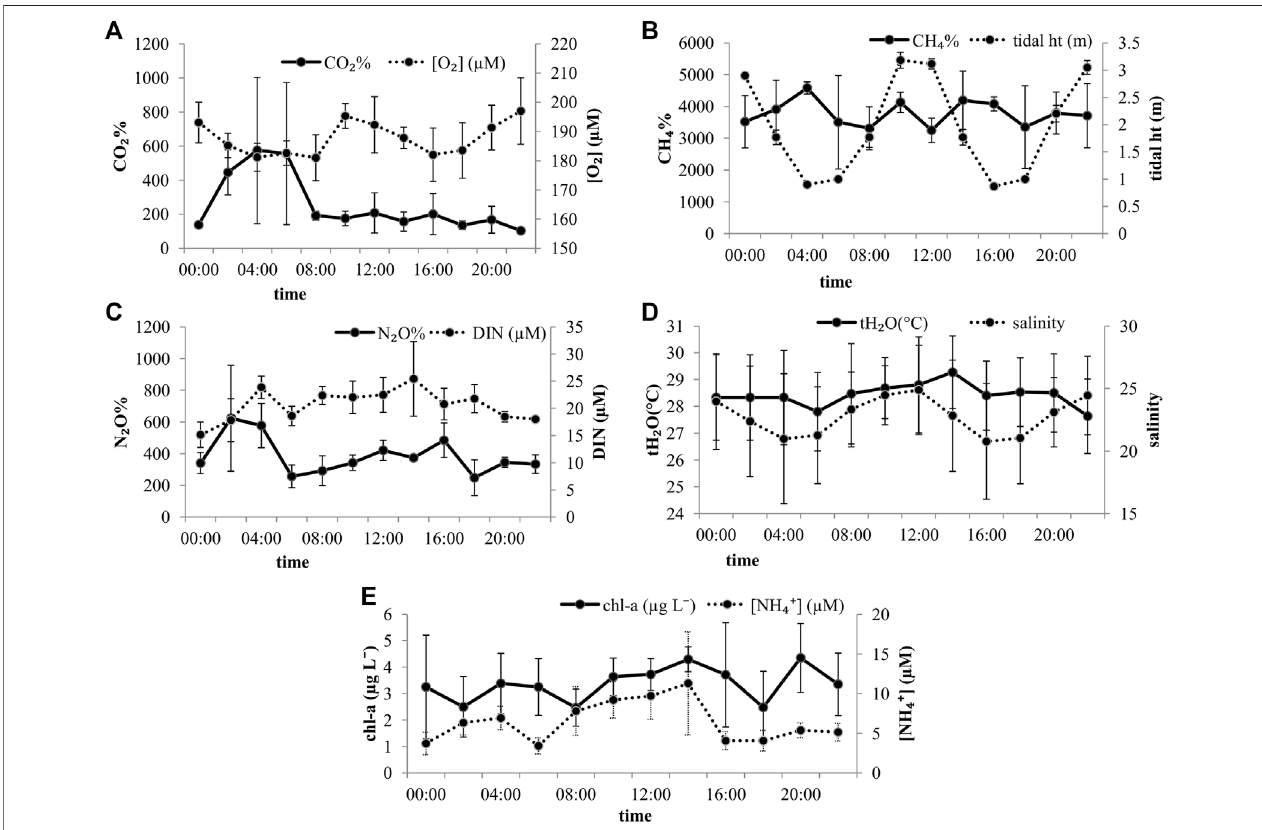
FIGURE 3 | Mean gas saturations and water chemistry across an average of three full tidal cycles at site 27, near Lothian Island in the Indian Sundarban estuary. Error bars equal the standard error of the mean (n = 3).